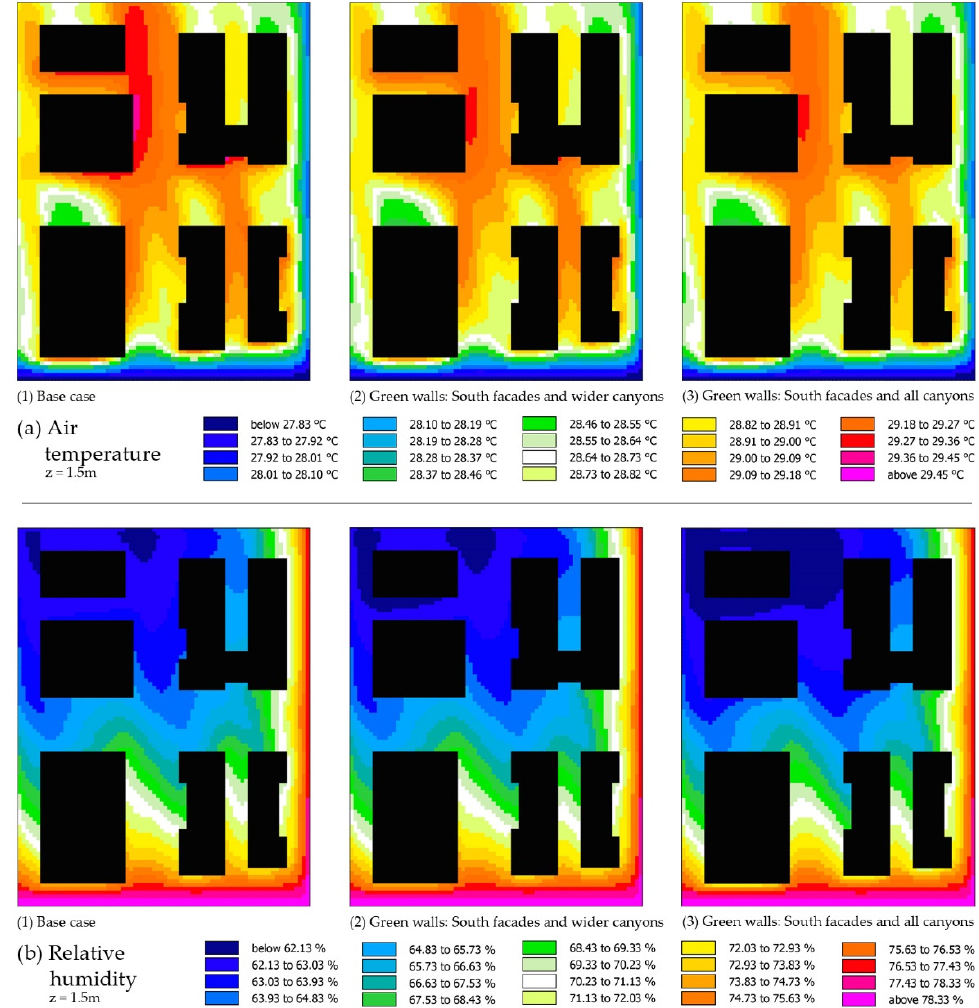
Figure 10. Distribution of the outdoor air temperature and the relative humidity for the base case ( a.1 and b.1 , respectively) and the map related to the introduction of the green walls on the buildings fronts, first for the southern oriented facades and the wider urban canyons and then, adding green walls for all urban canyons.